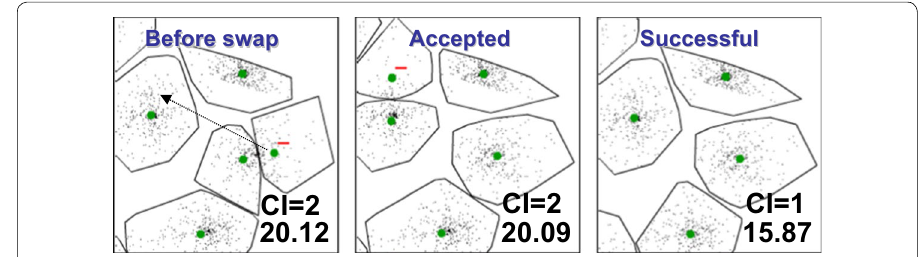
Fig. 6 Example of an accepted swap (middle) that improves SSE, and a successful swap (right) that also reduces the value of the centroid index (CI). Part of the dataset S 2 is